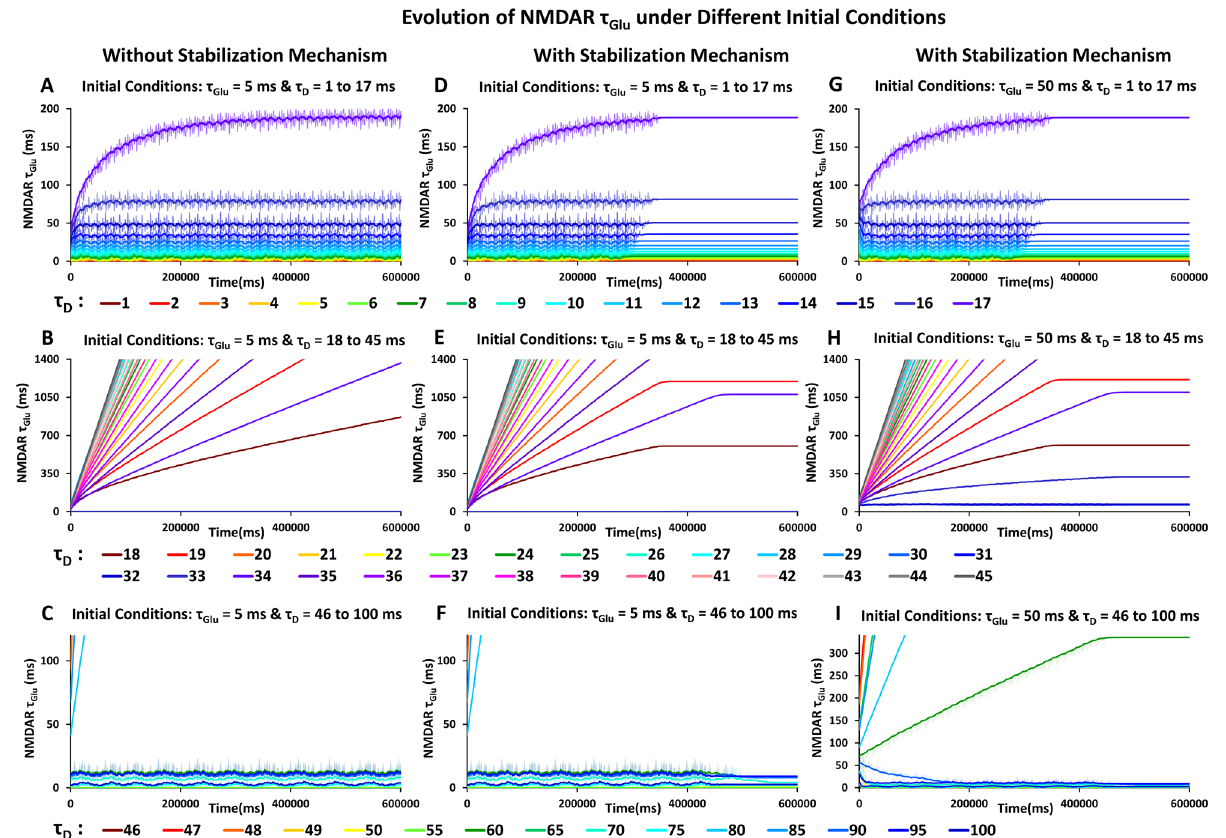
Figure 3. SITDL simulations with and without stabilization mechanisms, under different sets of initial conditions. Each curve shows the changes in τ Glu over time, for a single simulation with the specific initial τ D value indicated by the color of the curve. ( A) Changes in τ Glu when starting with τ Glu = 5 ms and different initial τ D value for each curve, ranging from 1 to 17 ms. By 600,000 ms simulation time, each curve appears to reach more stable values. ( B) Changes in τ Glu with initial conditions τ Glu = 5 ms and τ D value ranging from 18 to 45 ms. In most cases, τ Glu increases, but there does not appear to be sufficient simulation time for it to reach more stable values as in ( A) . ( C) Changes in τ Glu with initial conditions τ Glu = 5 ms and τ D value ranging from 46 to 100 ms, which provide much less overlap of glutamate and voltage signals. Certain τ D values, such as 49 to 60 ms, 70 to 75 ms, and 90 to 100 ms, seem to provide sufficient overlap for τ Glu to change significantly and potentially